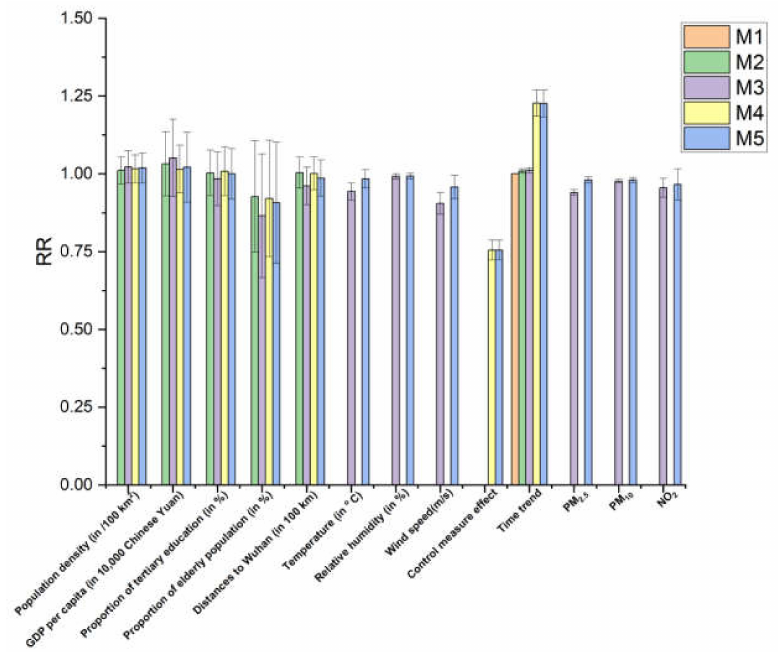
Figure 6. Compare the relative risks (95% confidence intervals) of variables among different schemes (RR: Relative risk in incidence rate of COVID-19 for each unit change in variable).